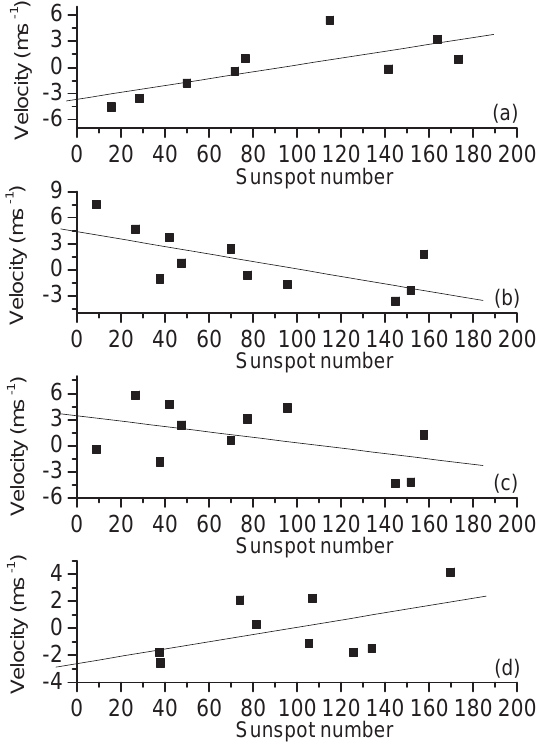
Fig. 9. Detrended seasonal-mean winds against seasonally- averaged sunspot number for (a) zonal winds in summer, (b) merid- ional winds in winter, (c) zonal winds in winter and (d) zonal winds in autumn. The best-fit straight line is indicated.